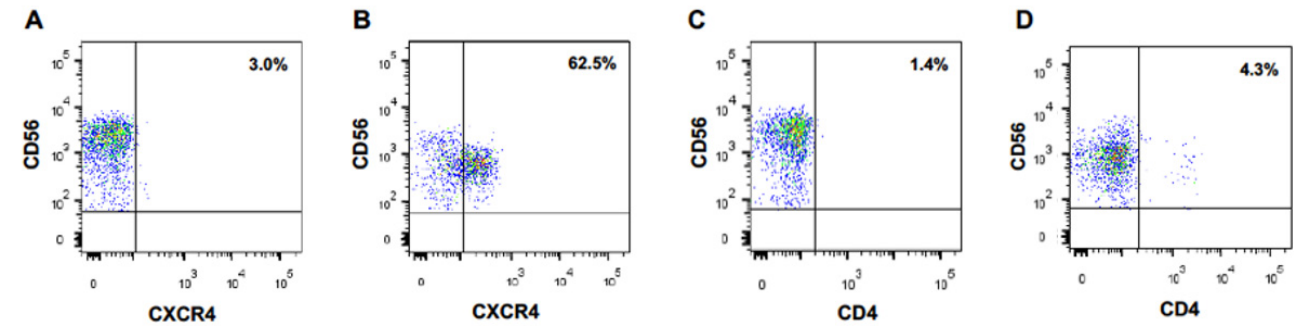
Figure 1. CD56-positive lymphoid cells acquire CXCR4 cell surface expression upon coculture with CXCR4-positive MT4 cells. CXCR4 ( A ) and CD4 ( C ) expression at the surface of primary CD56 + lymphocytes cells cultured alone. CXCR4 ( B ) and CD4 ( D ) expression at the surface of primary CD56 + lymphocytes cocultured overnight with MT4 cells.